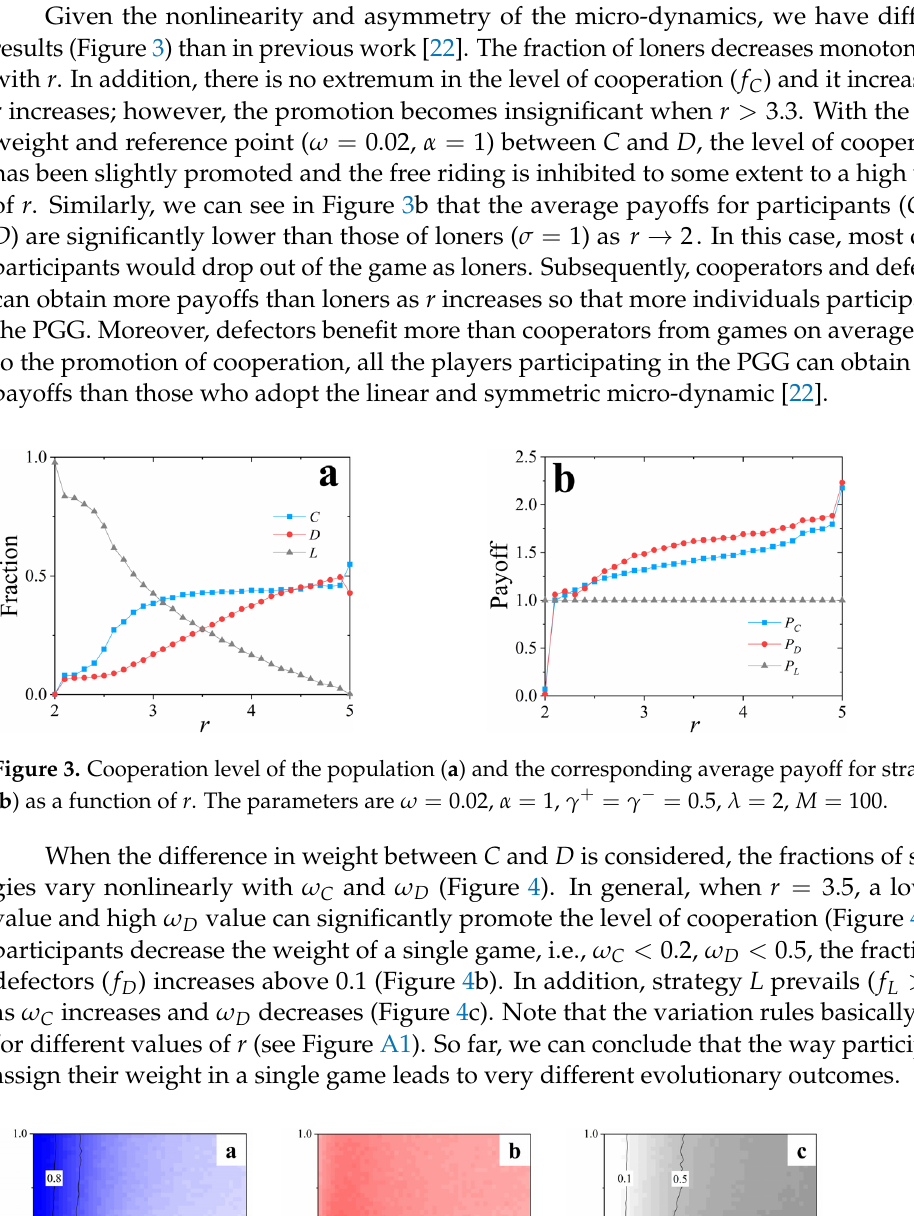
Figure 2. Schematic diagram of the asynchronous updating process.